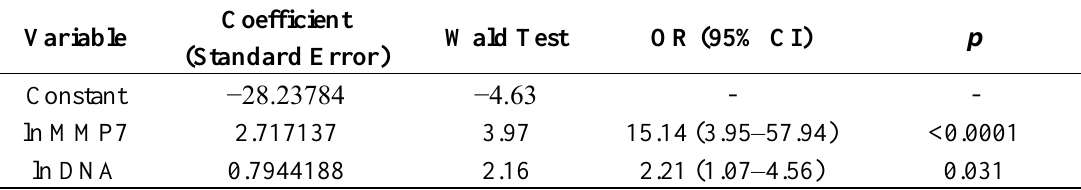
Table 7. Combined analysis of MMP-7 and free circulating DNA, considered as continuous variables in a multiple logistic regression model adjusted for age, gender and smoking habits of IPF patients compared to the other lung diseases and healthy